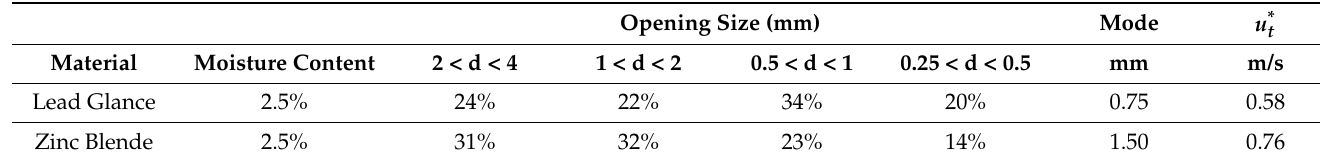
Figure 3. Aggregate size distribution for the samples of Lead and Zinc sulphides. Table 1. Aggregate size distribution and derived threshold friction velocity [4]. Table 2. Key properties of lead and zinc sulphides.